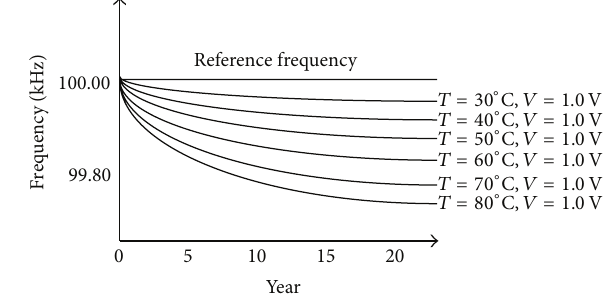
Figure 12: The aging